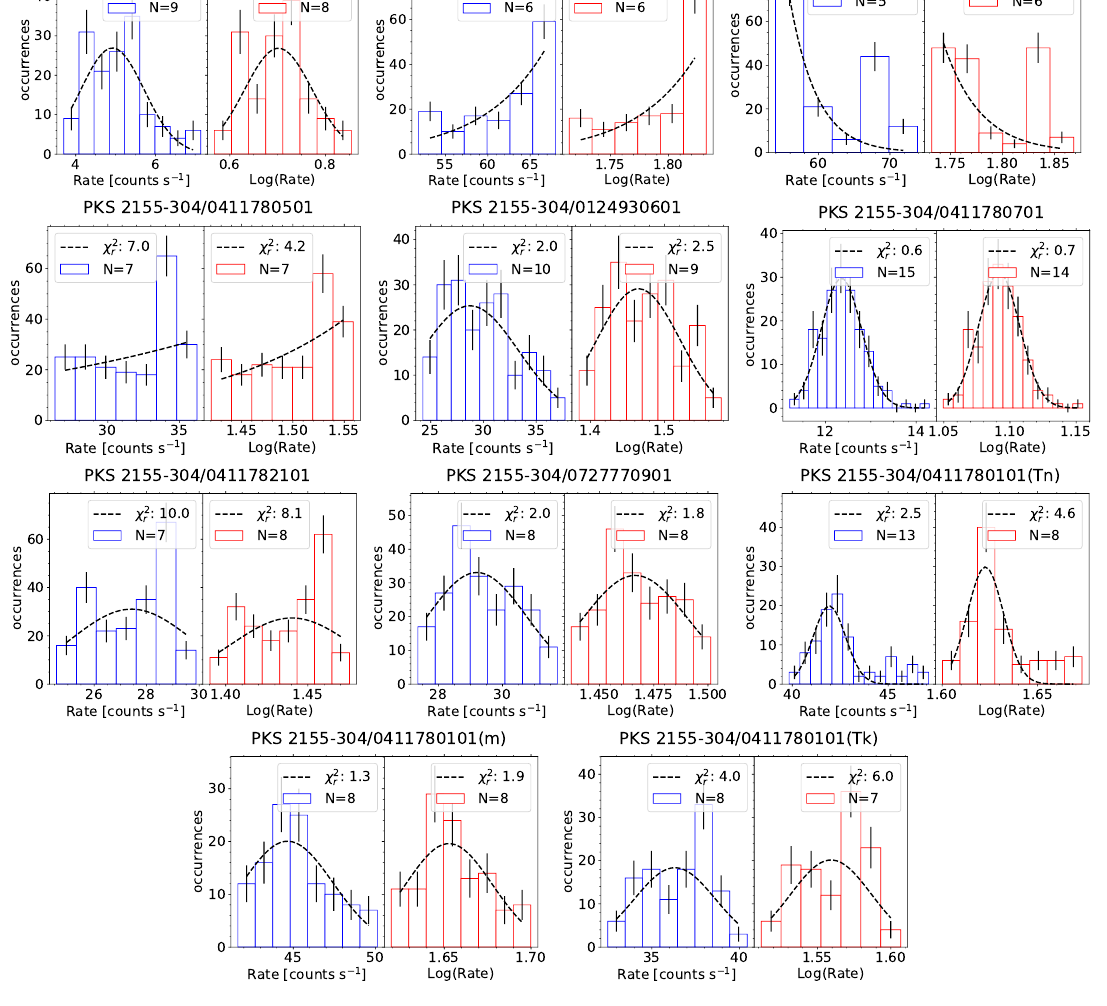
Figure 3. Histograms of total count rate (blue bars) and the logarithm (log) of the total count rate (red bars) for each ID. The dashed curve in the respective window is a Gaussian fit to the histogram and χ 2 r is the best-fit reduced- χ 2 value. N denotes the number of